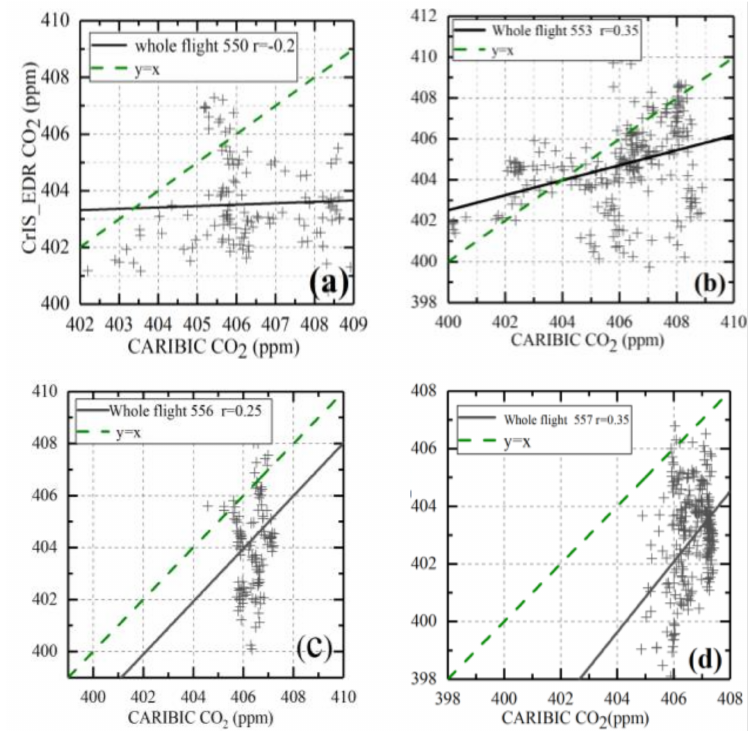
Figure 6. CO 2 comparison between smoothed CARIBIC and CrIS Environmental Data Records (EDR) with the spatial resolution of 0.5 ◦ × 0.5 ◦ ( a ) flight No. 550, ( b ) flight No. 553, ( c ) flight No. 556, ( d ) flight No. 557.